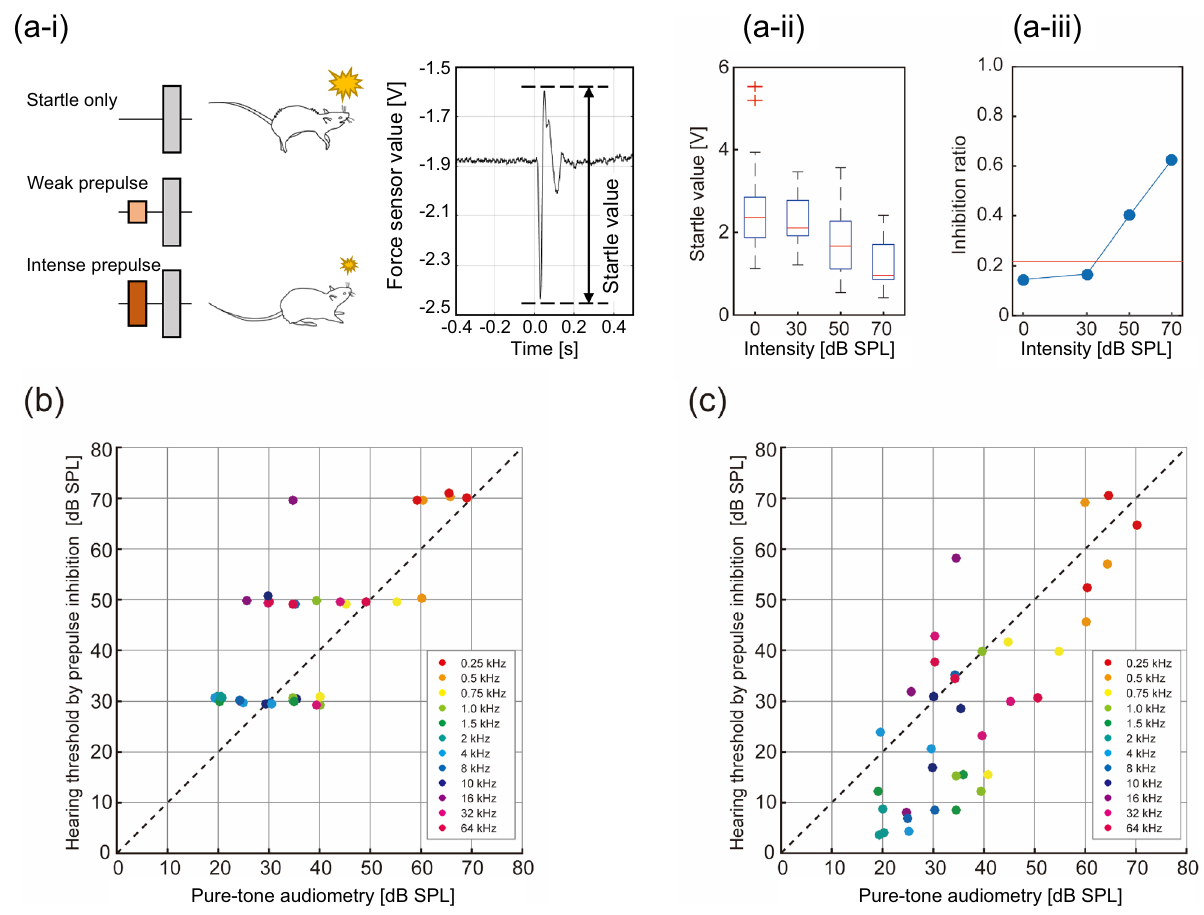
Figure 4. PPI-based audiogram in relation to behavioral audiogram. ( a-i , left pane) The schematic of stimuli presented for evoking the startle responses. ( a-i , right pane) Representative raw data of a force sensor output used to determine the strength of the startle response (startle value); ( a-ii ) The boxplots of startle strengths; ( a-iii ) The IR based on the startle strengths. The baseline of IR (red line) is the mean + 1σ of IRs under the startle only conditions across multiple days. The PPI threshold is defined as the smallest SPL where the IR exceeded the baseline. ( b ) The values of the PPI-based audiogram plotted against the values of the behavioral audiogram. ( c ) The values of the PPI-based audiogram after interpolating the IR function, plotted against the values of the pure- tone